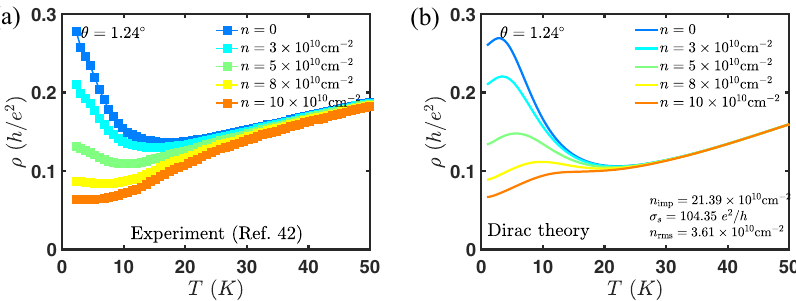
Fig. 7 The non-monotonic temperature dependence at low temperatures and linear-in- T dependence at intermediate temperatures seen in experiment is well captured within the Dirac theory of electron – (gauge) phonon scattering 40 . Resisitivity vs temperature from a ref. 42 and b Dirac theory 40 at twist angle of θ = 1.24 ∘ . The non-monotonicity at low temperatures is due to the crossover from impurity-dominated transport to phonon-dominated